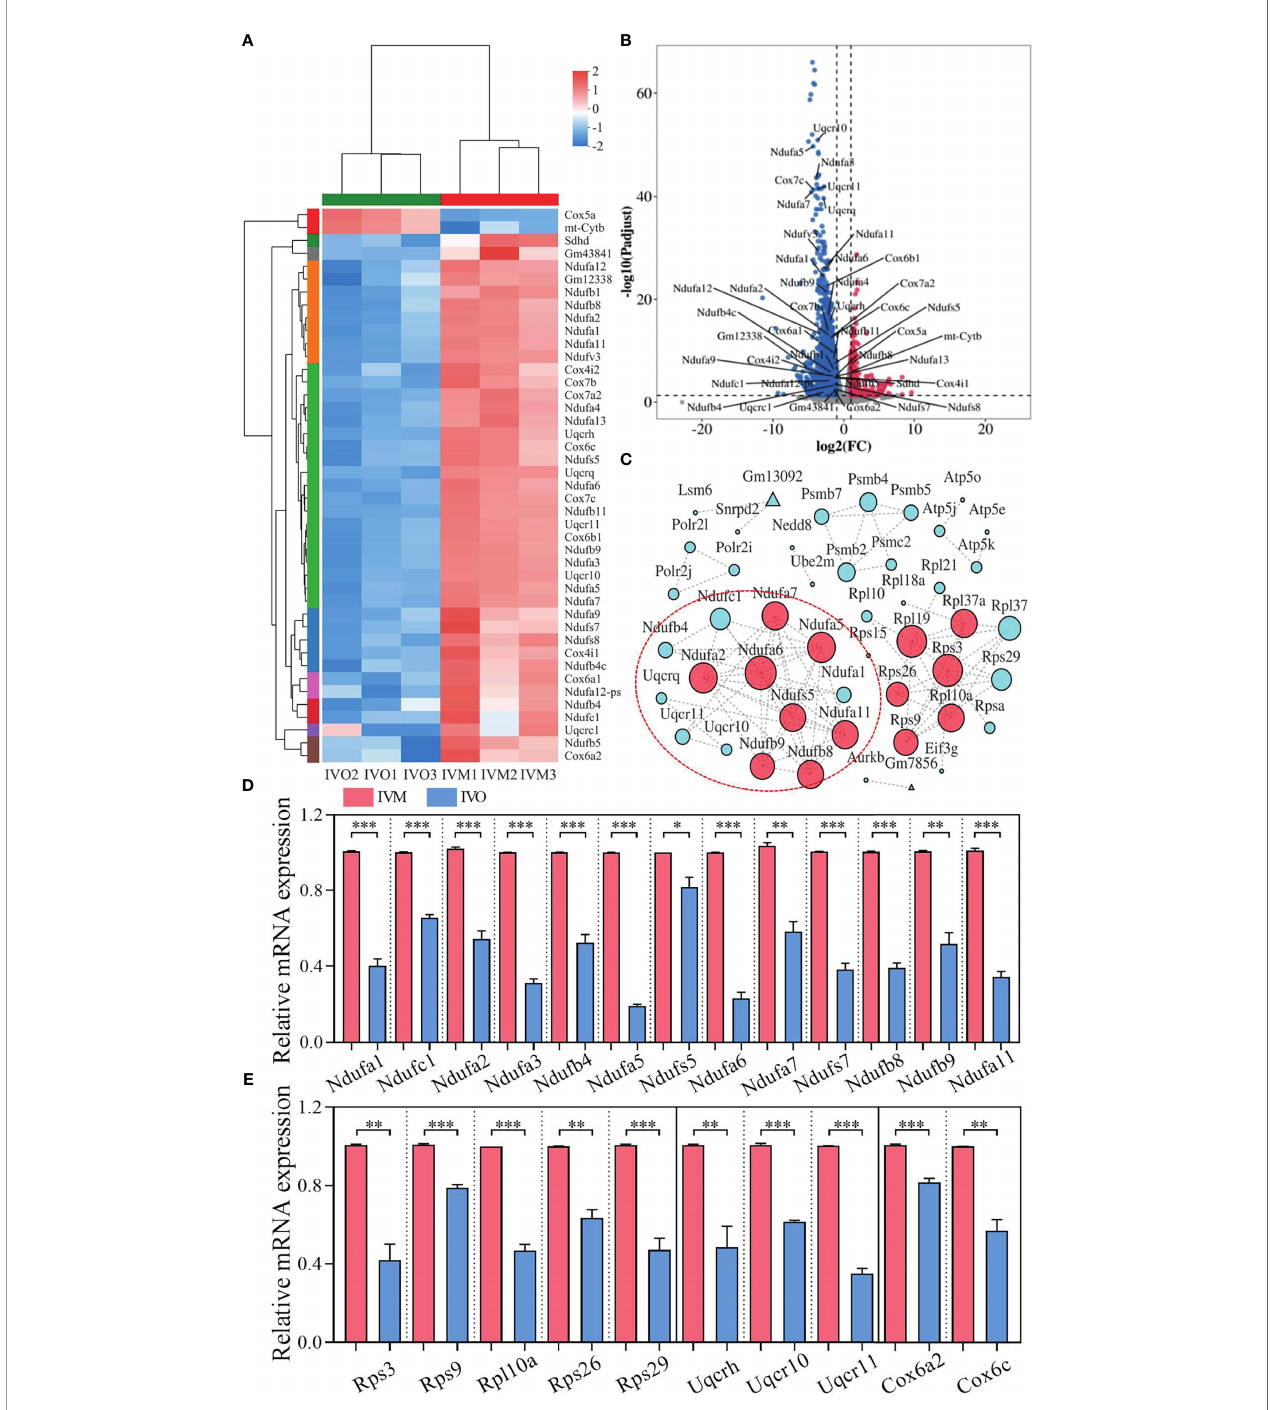
FIGURE 3 | DEG analysis and network patterns for the top four enriched KEGG pathways. (A) Heatmap diagram showing the top four enriched KEGG pathways with overlapping DEGs ( P -adjusted < 0.05 and |log2FC| ≥ 1). (B) Volcano plots showing overlapping DEGs in the top four KEGG enrichment analyses. Blue dots indicate down-regulated genes while red dots indicate up-regulated genes. (C) A PPI network for the down-regulated genes was constructed using the STRING database to compare the IVO and IVM groups. The node size represents the number of linked lines and connectivity. (D, E) The relative mRNA levels of DEGs including NADH-ubiquinone oxidoreductase (complex I) subunits, the ribosomal protein family, ubiquinol-cytochrome c reductase subunits, and cytochrome c oxidase subunits between the IVM and IVO groups, as determined by RNA-seq and con fi rmed by qRT-PCR assay. Data represent the mean ± SEM of three independent experiments. * P < 0.05, ** P < 0.01, and *** P <